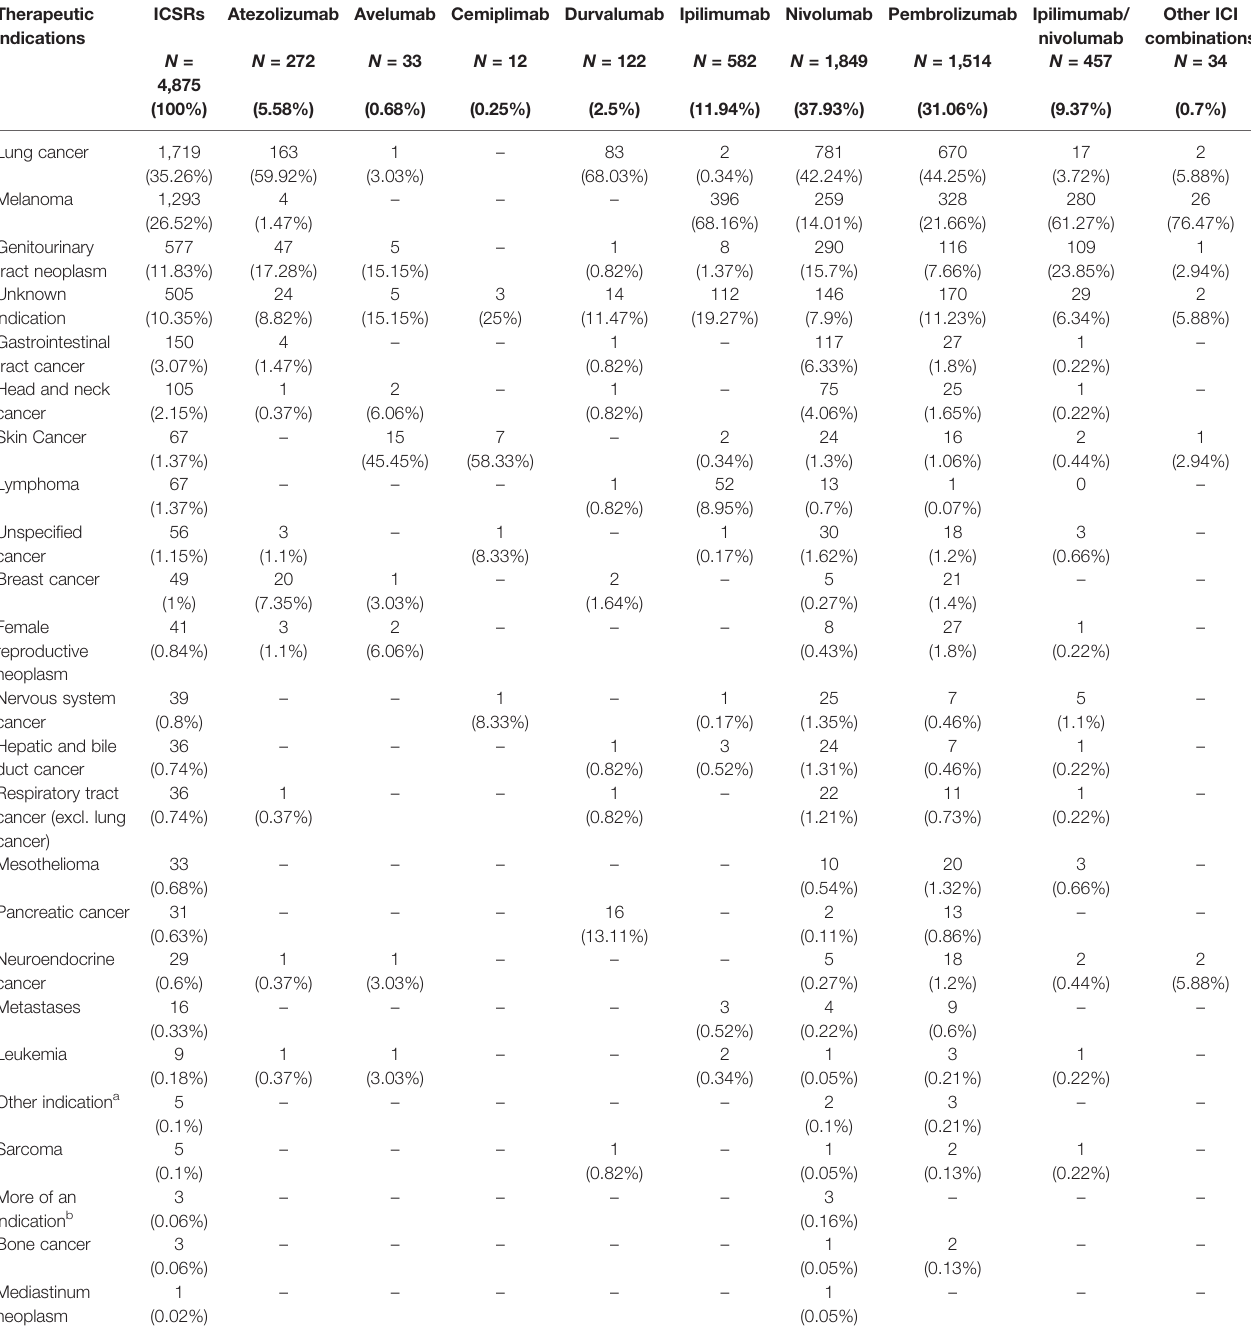
TABLE 2 | Distribution of therapeutic indication ICI therapies involved in the neurological complications collected in the European database EudraVigilance until February 7, 2020. Therapeutic